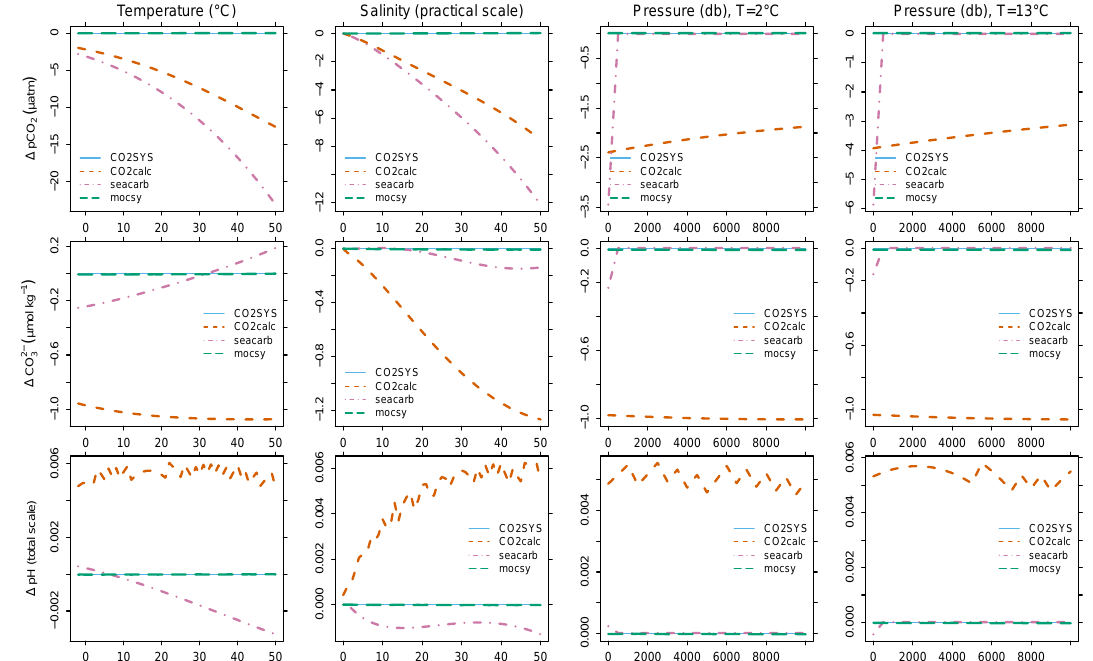
Figure 12. Variables computed from A T and C T with each package minus corresponding results from CO2SYS-MATLAB, as in Fig. 5 but with K 1 and K 2 from Millero (2010) instead of from Lueker et al. (2000). Shown are computed p CO 2 (top), CO 2 − (bottom) across ranges of T (column 1), S (column 2), and P when T = 2 ◦ C (column 3) and when T = 13 ◦ C (column 4).